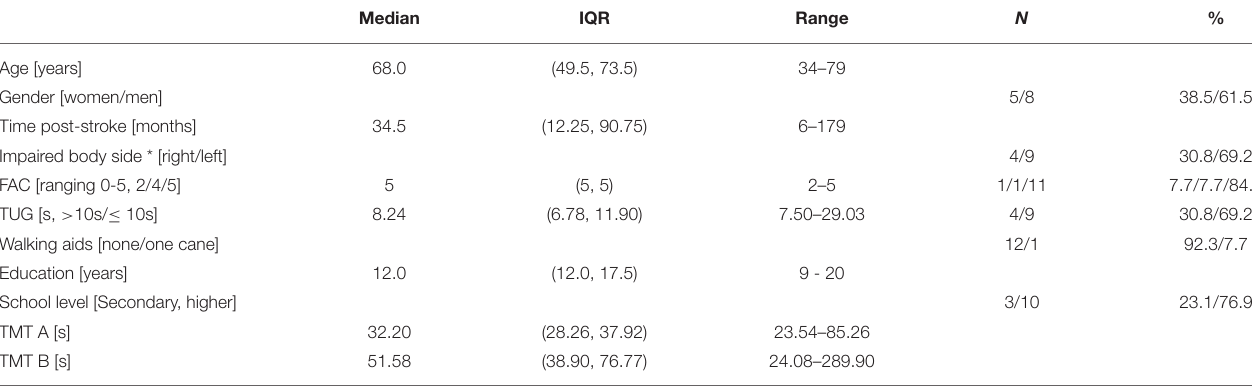
TABLE 2 | Baseline